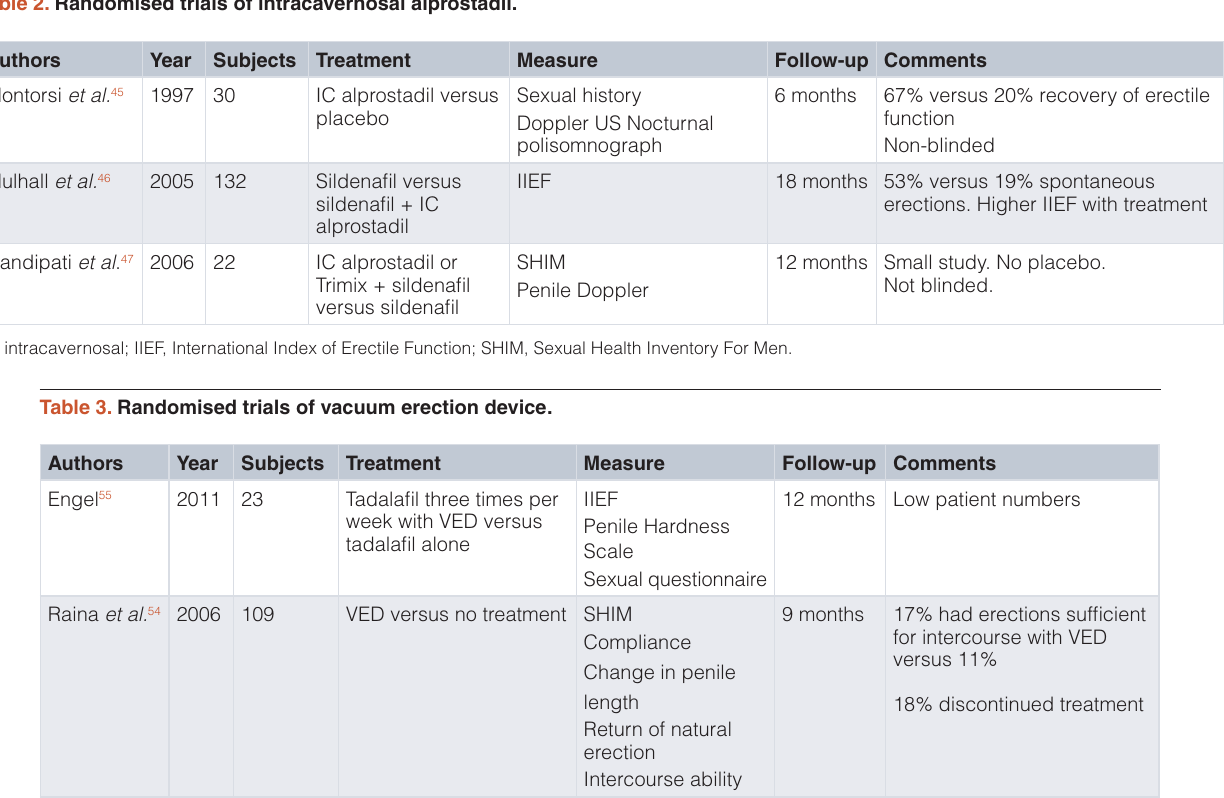
Table 2. Randomised trials of intracavernosal alprostadil.